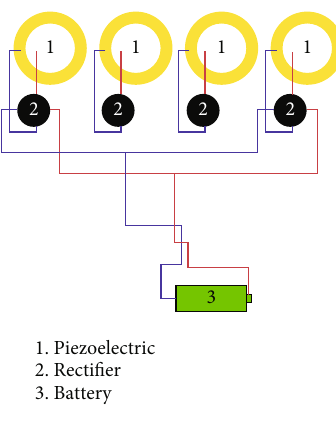
Figure 2: Piezoelectric circuit diagram.